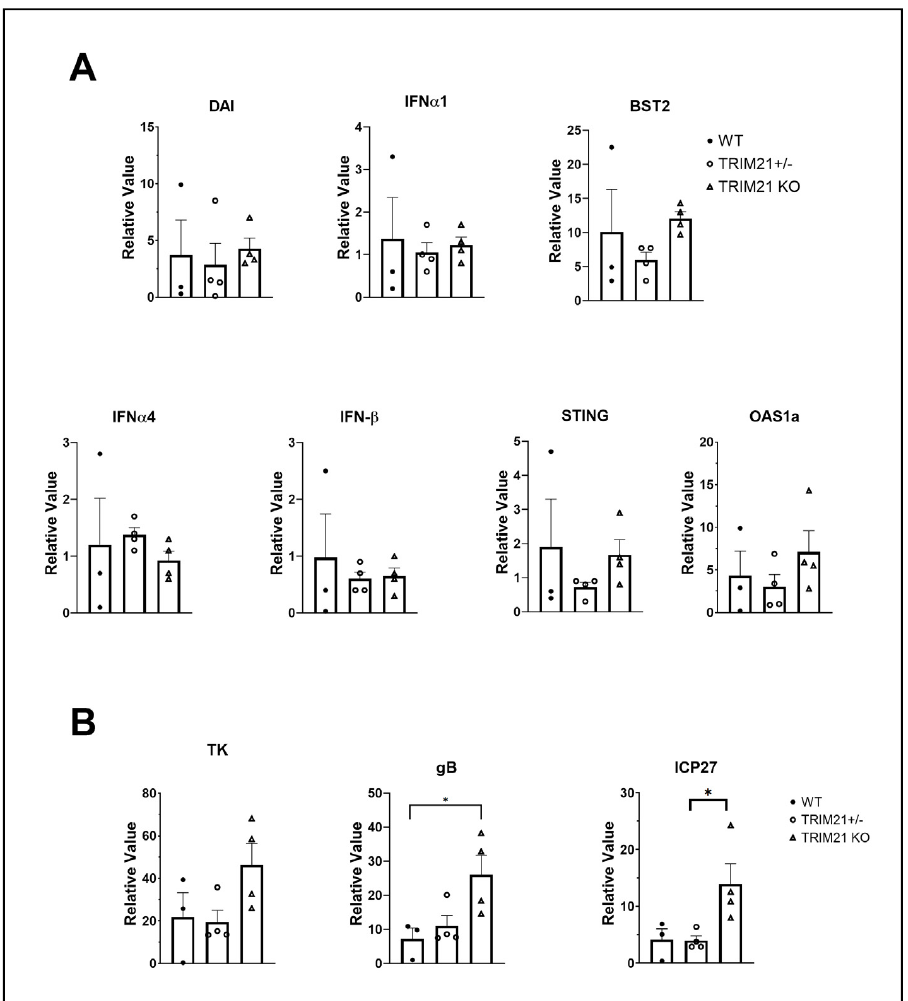
Figure 9. Elevation in HSV-1 lytic gene expression does not correlate with type I IFN gene expression. Female C57BL/6 (WT), TRIM21+/ − , and TRIM21 KO mice (n = 4/group) were infected with HSV-1 (10 3 PFU/cornea). At day 7 pi, the mice were exsanguinated, and the TG were removed and processed for select gene expression by real-time RT-PCR. ( A ) Relative values for Bst2 (tetherin), DNA-dependent activator of interferon regulatory factors (DAI), IFN- α 1, IFN- α 4, IFN- β , STING, and oligoadenylate synthetase (OAS)1a and ( B ) HSV-1 lytic genes infected cell protein (ICP)27, thymidine kinase (TK), and glycoprotein B (gB) were determined using the ∆ Ct method, using uninfected genotypes as the controls to establish a baseline (relative value = 1). Bars represent the mean + SEM, * p < 0.05, comparing the indicated group as determined by Kruskall–Wallis ANOVA and the Holm–Sidak post hoc t-test.